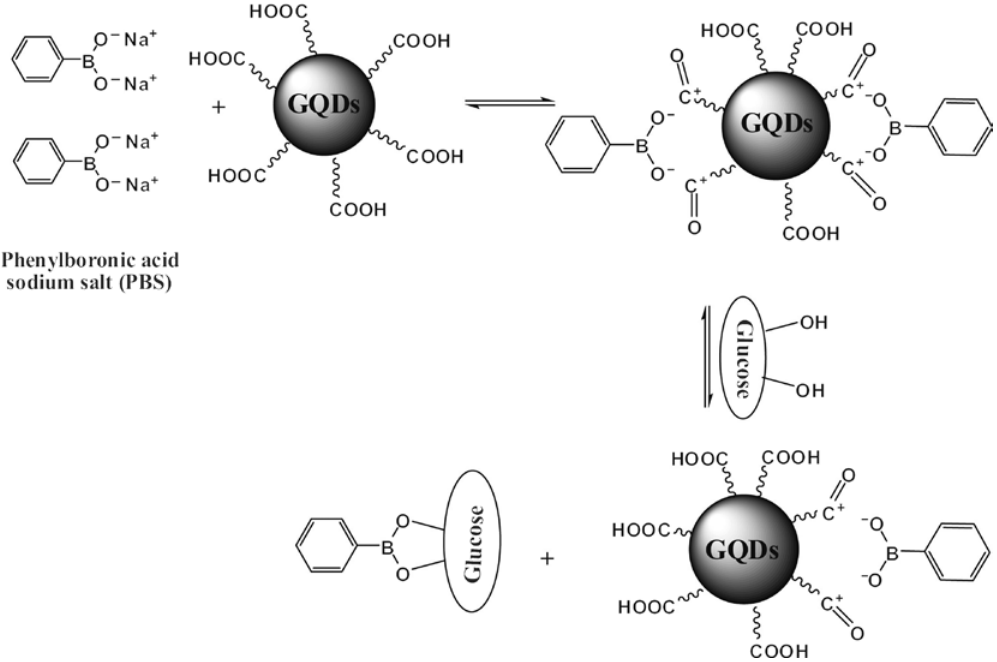
Figure 17: Representation scheme of the proposed enhancement and quenching mechanism of GQDs fluorescence (reprinted/reproduced with the permission of Ref. [110], copyright 2017, Elsevier